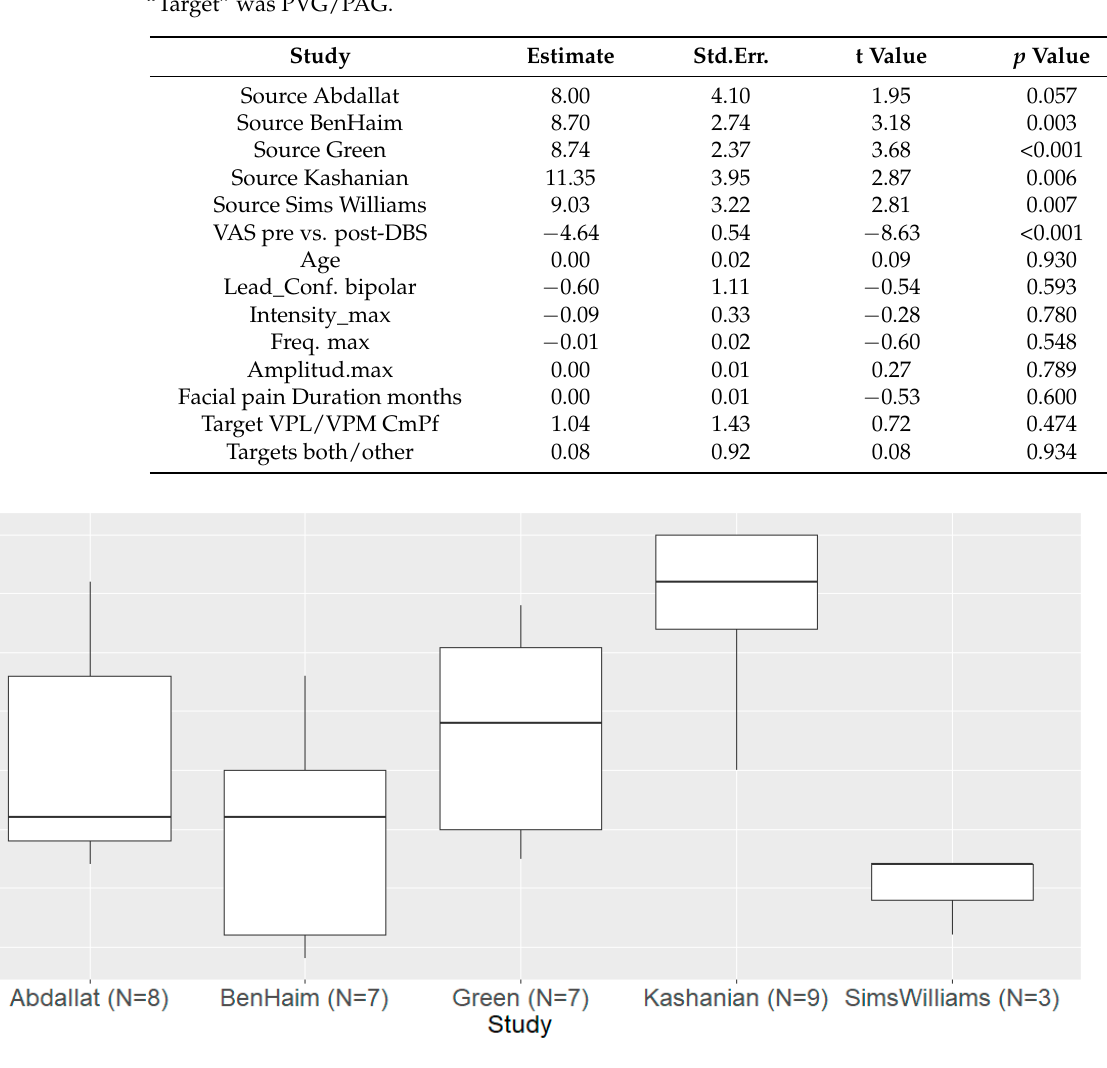
Figure 2. The VAS level changes pre- and post-DBS at 3 months (T1) follow-up for the included studies as per the study definition. The boxplot shows the median, the upper and lower quartiles, and the two whiskers. The upper whisker extends from the upper quartile to the largest value no further than 1.5 × IQR from the upper quartile, where IQR is the inter-quartile range, or distance between the upper and lower quartiles. The lower whisker has an analogous definition.